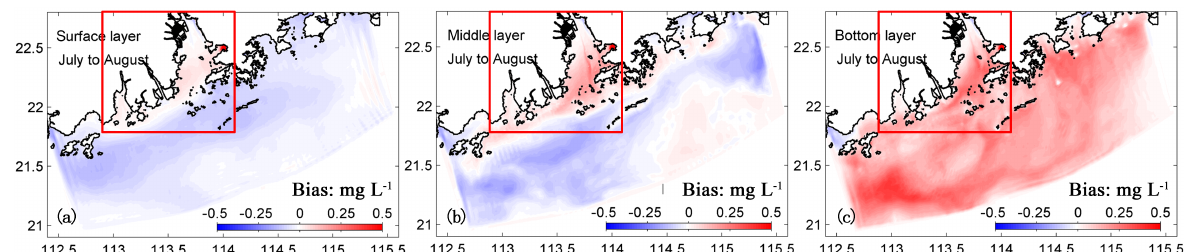
Figure 8. Spatial distributions of the biases of the simulated DO concentrations (averaged over July–August 2006) between the physical modulation method and the water quality model (RCA). Note that positive values (red) indicate that the physical modulation method overes- timates the DO concentrations simulated by RCA, while negative values indicate underestimations. The red box represents the main part of the Pearl River estuary (PRE), which is the area of interest in this